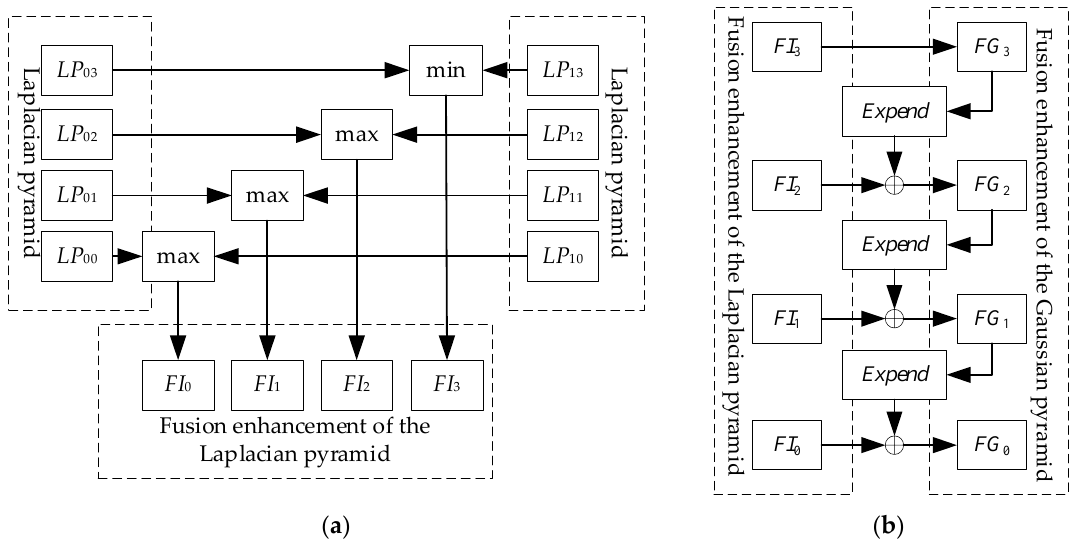
Figure 4. The process of the fusion enhancement. ( a ) The process of Laplacian pyramid; ( b ) the process of Gaussian pyramid.